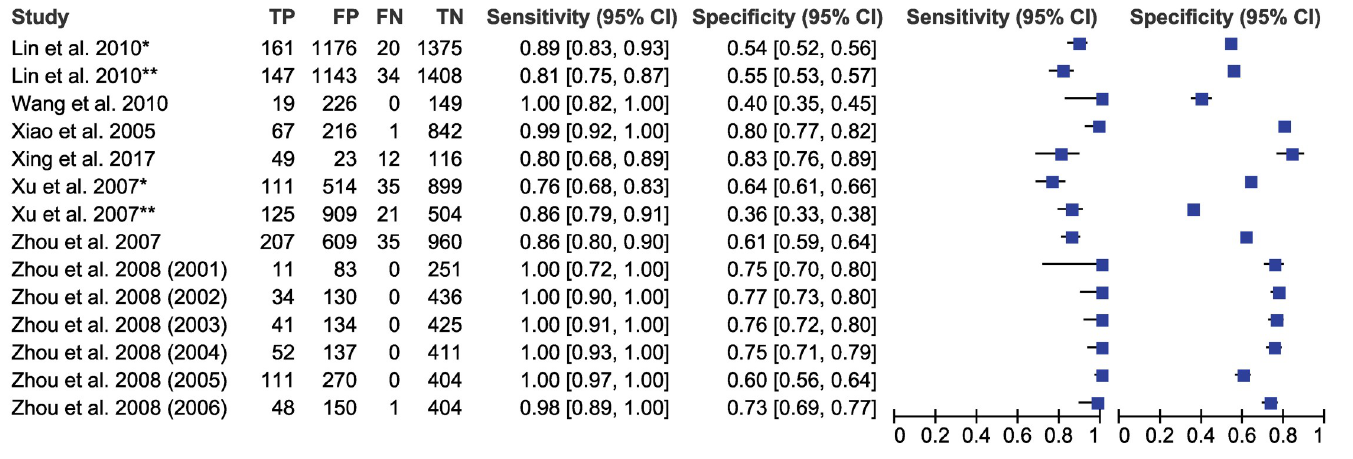
Fig 3. Forest plot of sensitivity/specificity of IHA ( S . japonicum with stool examination as a reference standard). Note: � -IHA_A; �� -IHA_B.